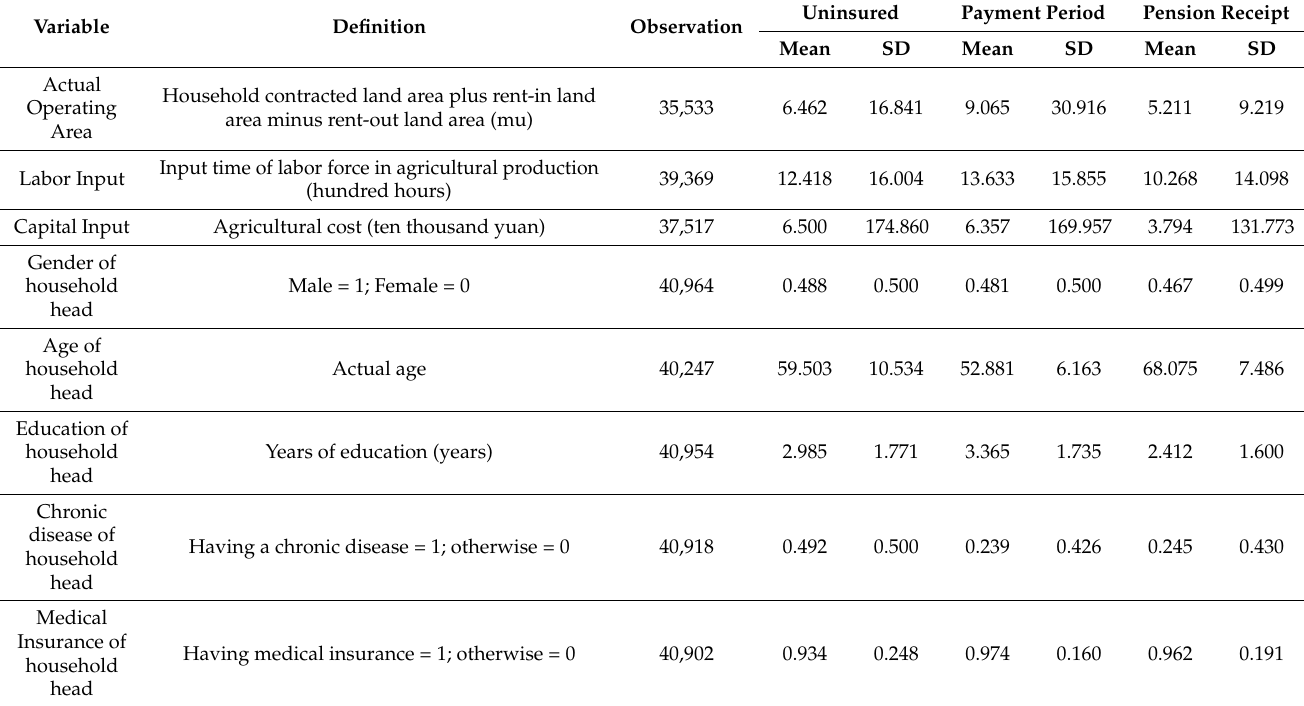
Table 1. The definitions and descriptive statistics of the